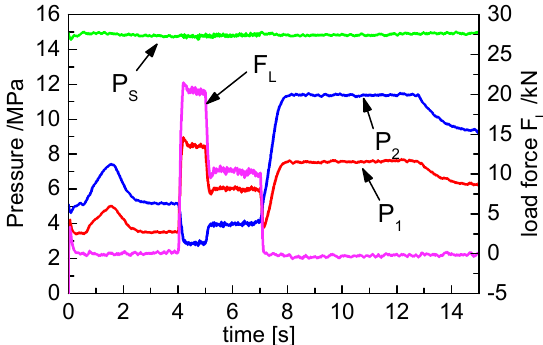
Figure 16. Values of p s , p 1 , p 2 , and F L of the electro-hydraulic servo system (EHSS).